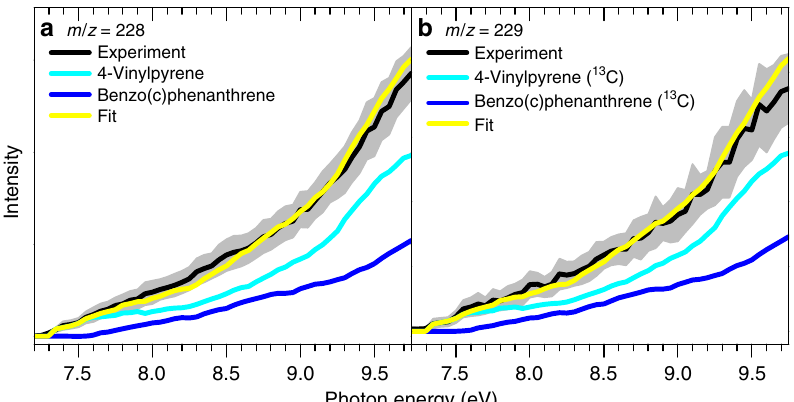
Fig. 3 Photoionization ef fi ciency (PIE) curves relevant to the formation of [4]-helicene. a m/z = 228 and b m / z = 229. Black: experimentally derived PIE curves; blue: [4]-helicene (benzo[c]phenanthrene) reference PIE curve; cyan: 4-vinylpyrene PIE curve; yellow: overall fi t. The overall error bars (gray area) consist of two parts: ±10% based on the accuracy of the photodiode and a 1 σ error of the PIE curve averaged over the individual